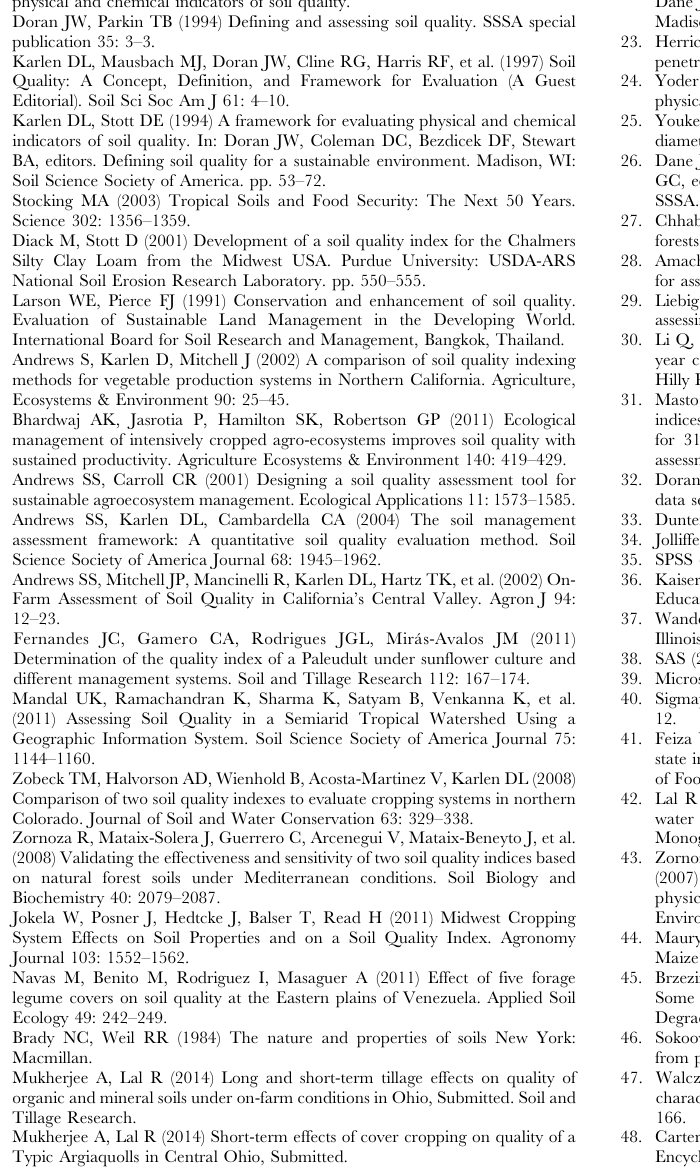
Figure S1 Percentage contribution of each soil function in SQI-2 under different soils in four soil layers; different letters indicate significant differences